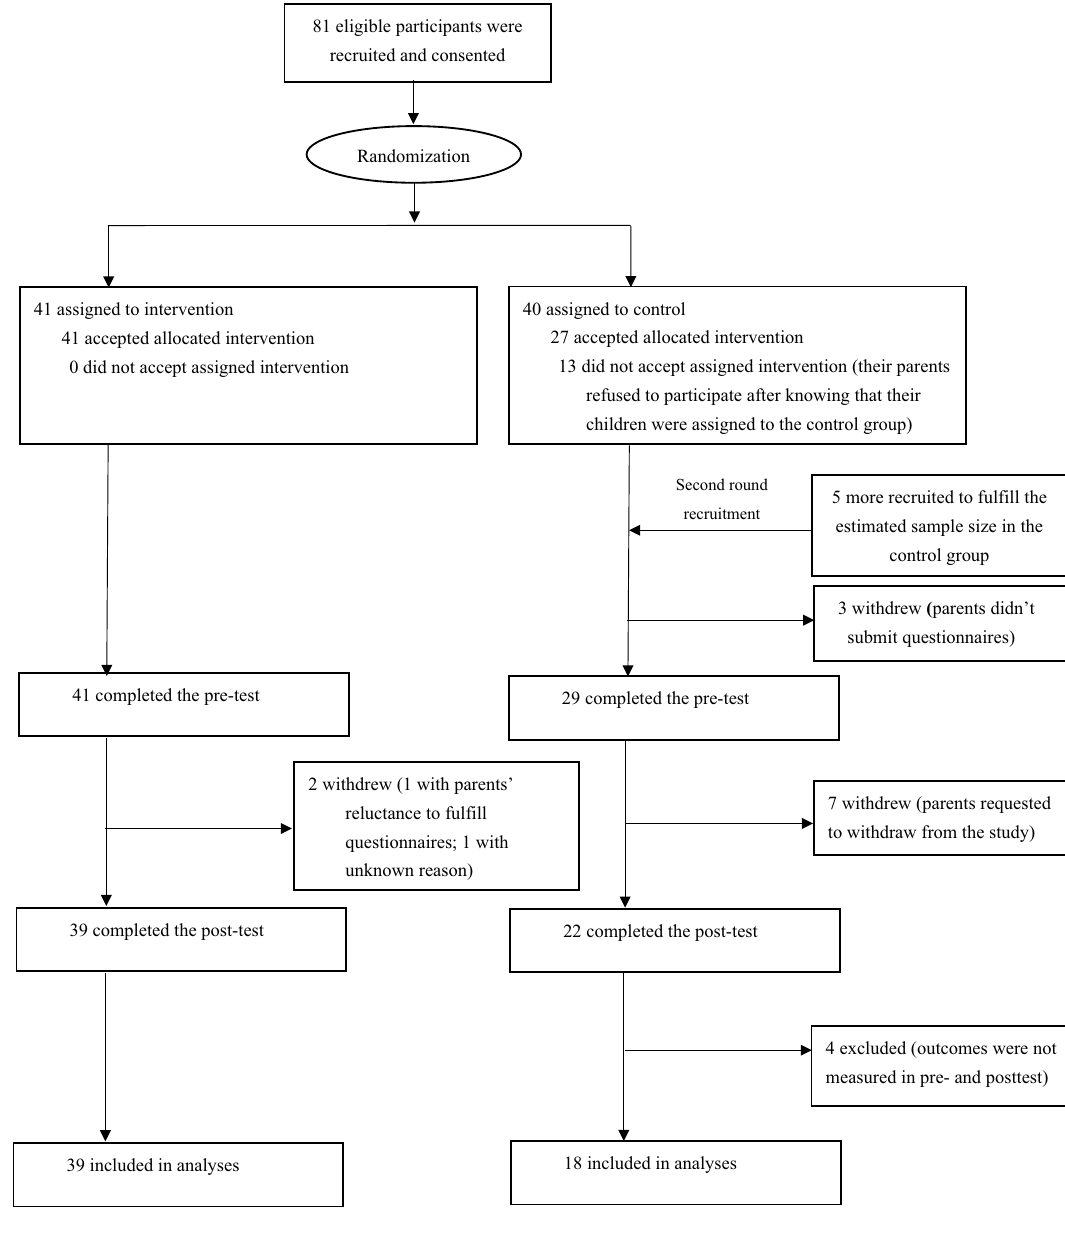
Figure 1. Flow diagram of participants in the